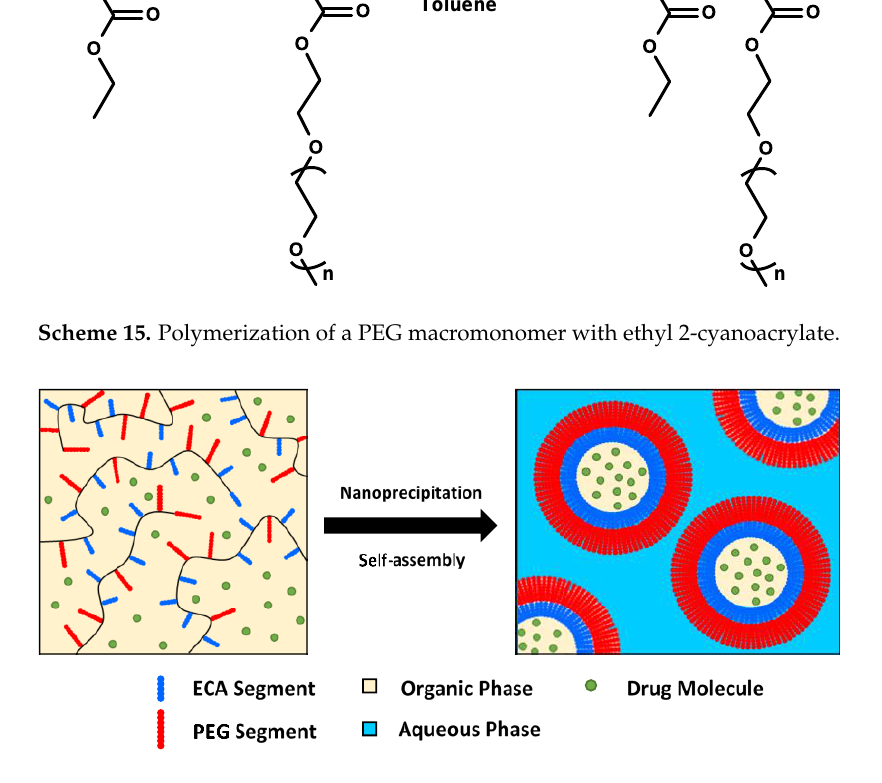
Figure 3. Formation of nanocapsules by polymer self-assembly.